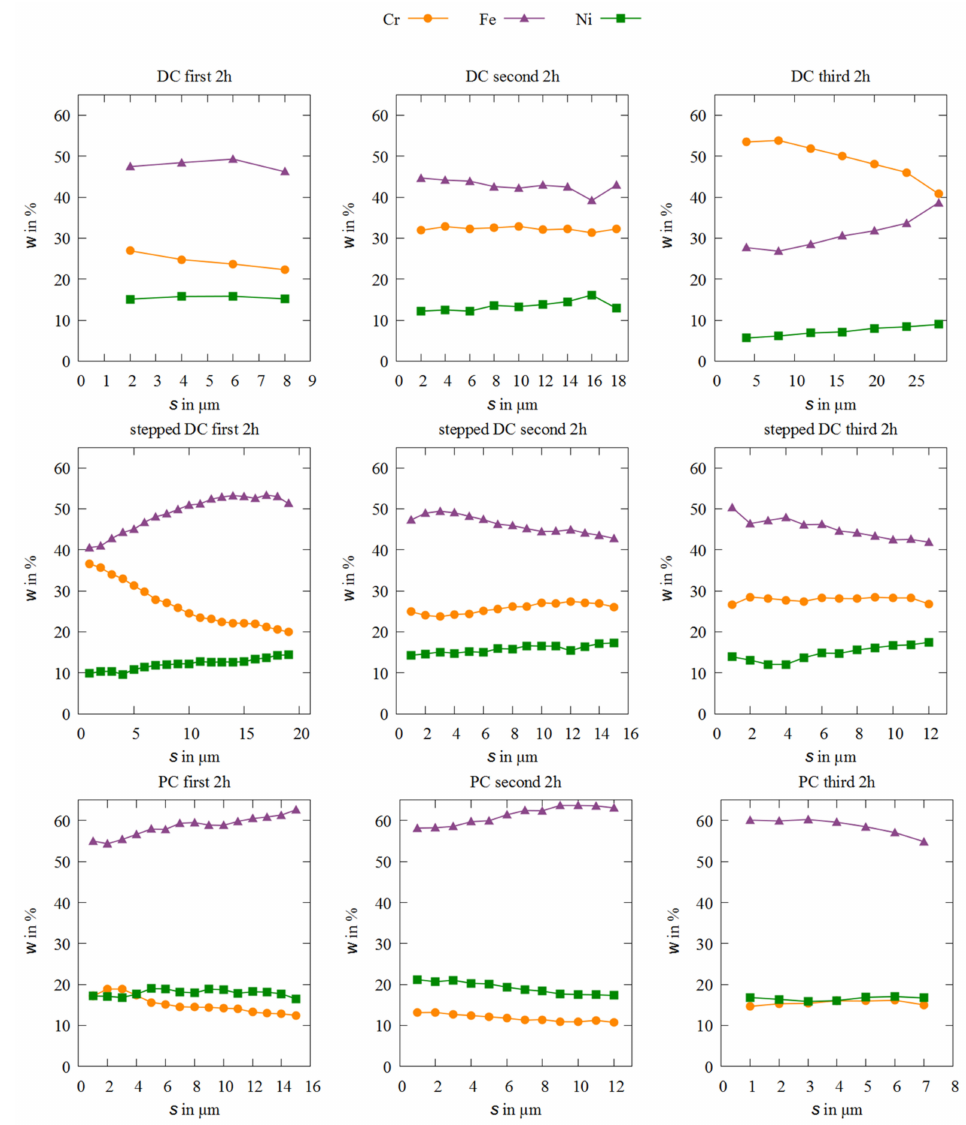
Figure 3. EDXS measurements of alloy compositions over the entire layer thickness for each sample depending on the deposition mode and the electrolyte